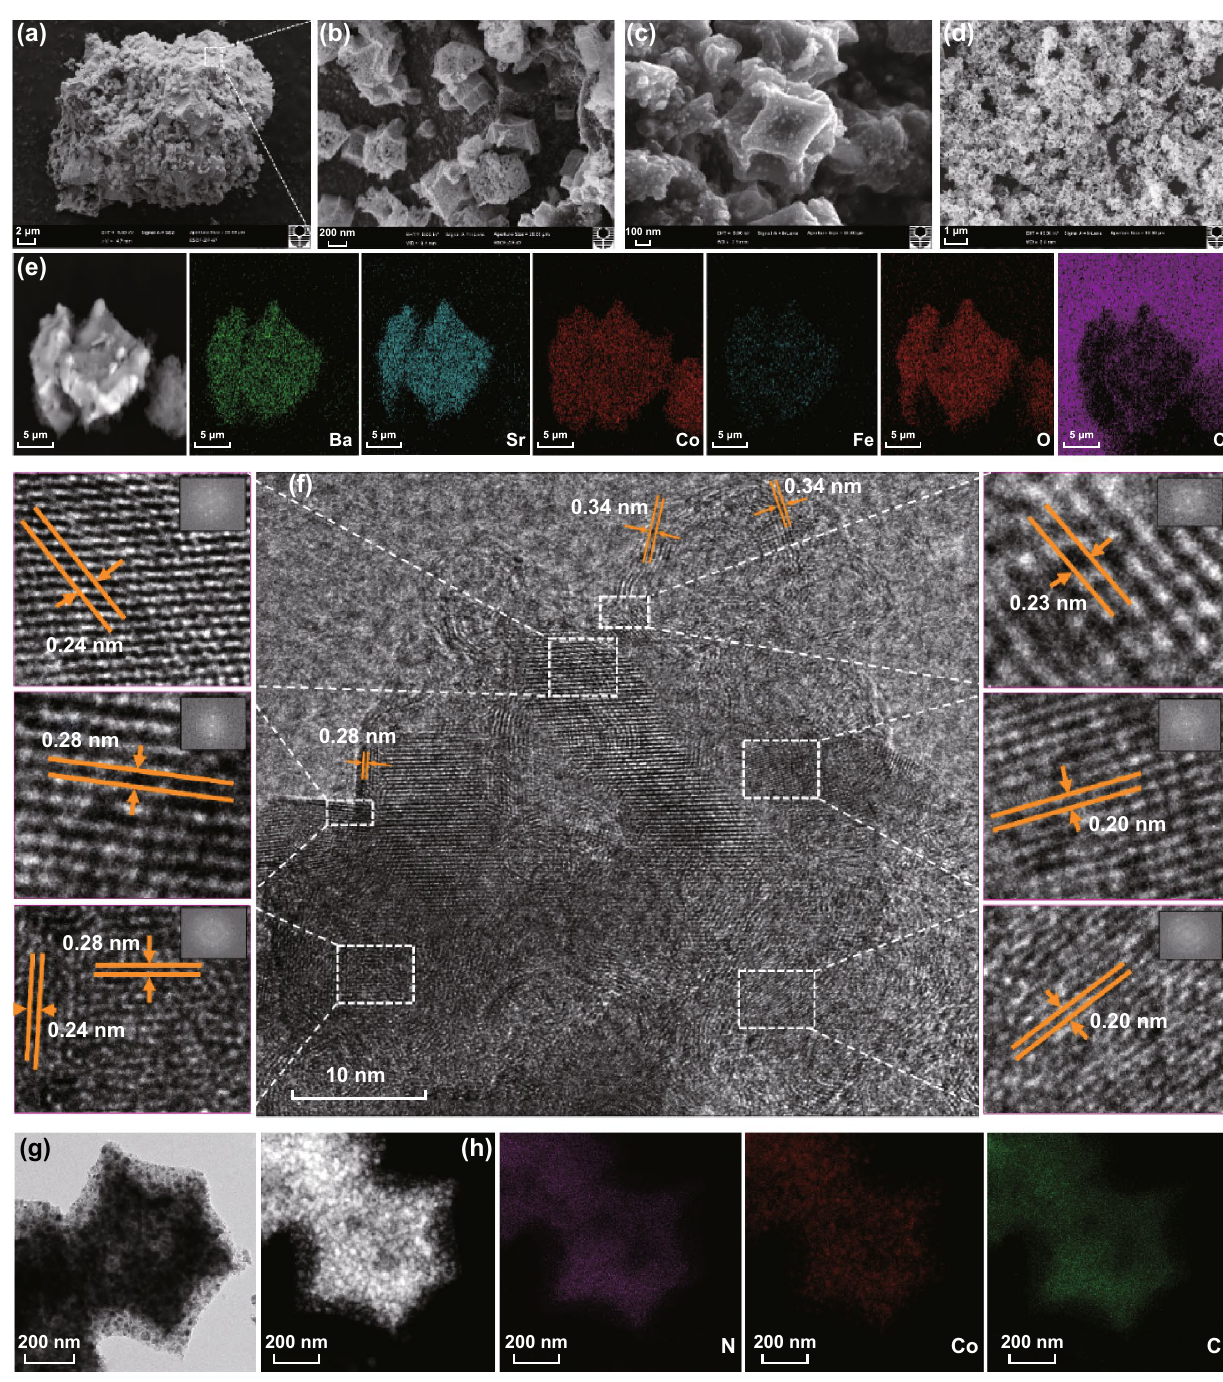
Fig. 1 a, b Scanning electron microscopy (SEM) of BCZ1 sample illustrating the ZIF‑67 crystals growth on BSCF particles, c magnified image of C‑ZIF‑67 crystals on BCZ1 and d BCZ2, e Corresponding energy dispersive X‑ray spectroscopy (EDX) element mapping of BCZ2, f HRTEM of selected area of BCZ2, insets show the fast Fourier transform (FFT) patterns corresponding to six spots, g TEM image of carbonized ZIF‑67 crystals, h STEM–HAADF image and corresponding elemental mapping of N, Co, and C elements of carbonized ZIF‑67